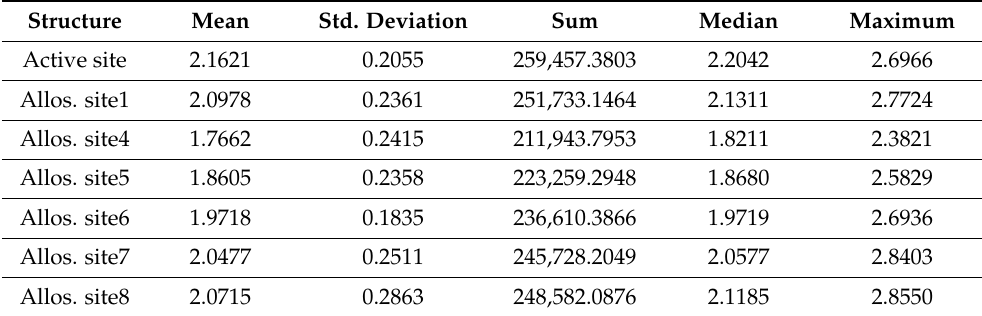
Table 3. Analysis of the RMSD (in Å) scores over the 120 ns simulation time. Std. represents standard, and zero is the minimum RMSD value in all cases. Allos. site equals allosteric site.